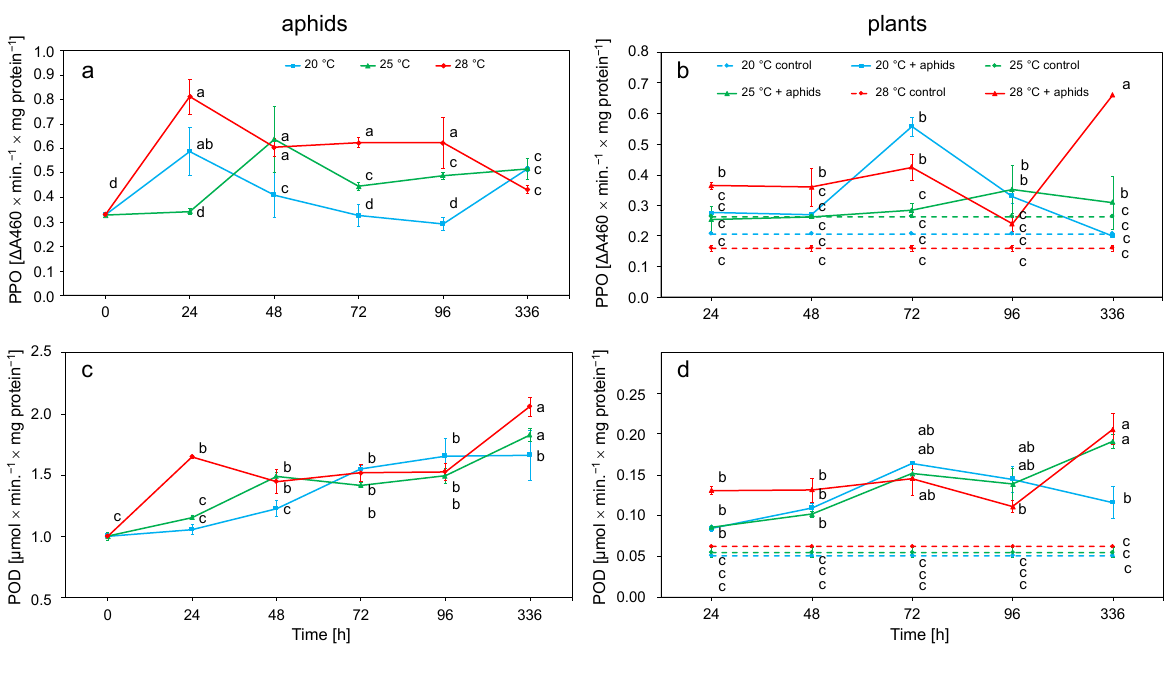
Figure 5. Changes in the PPO and POD activity (means ± SE) in the tissues of Macrosiphum rosae ( a , c ) and Rosa rugosa at different temperatures and during aphid feeding ( b , d ). Values marked with different letters differ significantly at p < 0.05 (Duncan